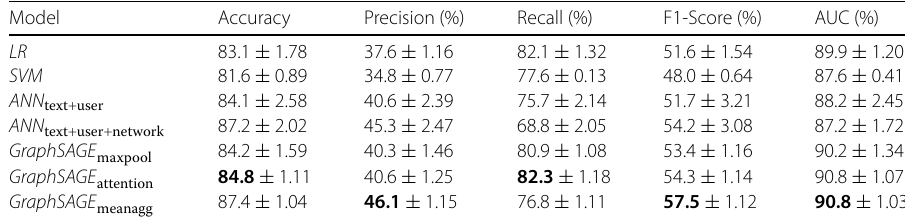
Table 2 Performance metrics ± standard deviations (Maximum mean columnar values in bold) Model Accuracy Precision (%) Recall (%) F1-Score (%) AUC (%)